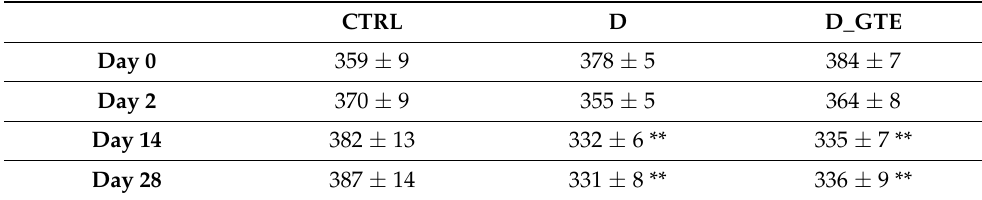
Table 3. Mean values ± SEM of body weights (g) measured weekly in the CTRL group, and untreated (D) and GTE-treated (D_GTE) diabetic animals, at different time points during the experimental protocol. ** p < 0.01 vs. CTRL (Two-way